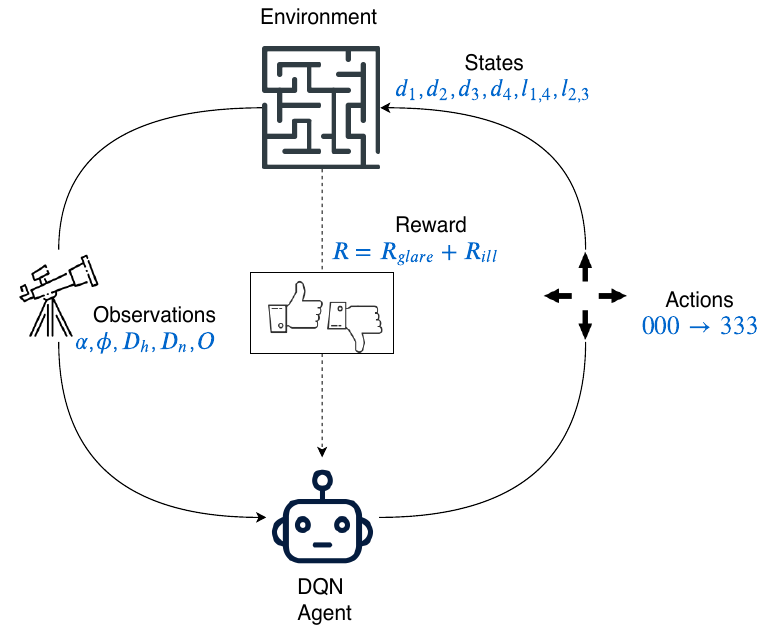
Figure 5. DQN agent with observations, states, rewards and